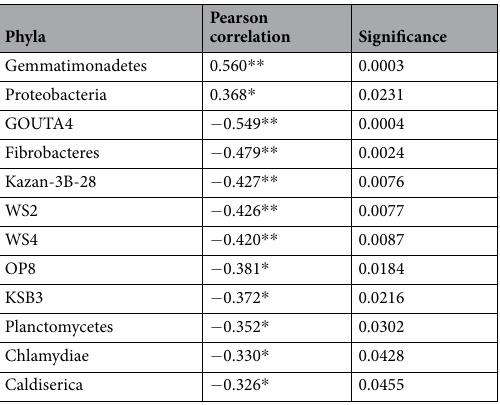
Table 2. Correlation between Cd content in sludge and the microbial composition at the phylum level. * Represents significant at the level of 0.05. ** Represents significant at the level of